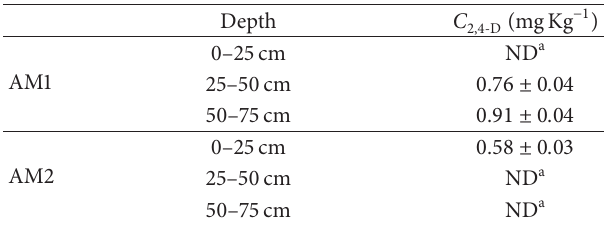
Table 4: Concentration of 2,4-D in the soil solutions extracted from the soil samples collected with an auger after 100 days of the herbicide